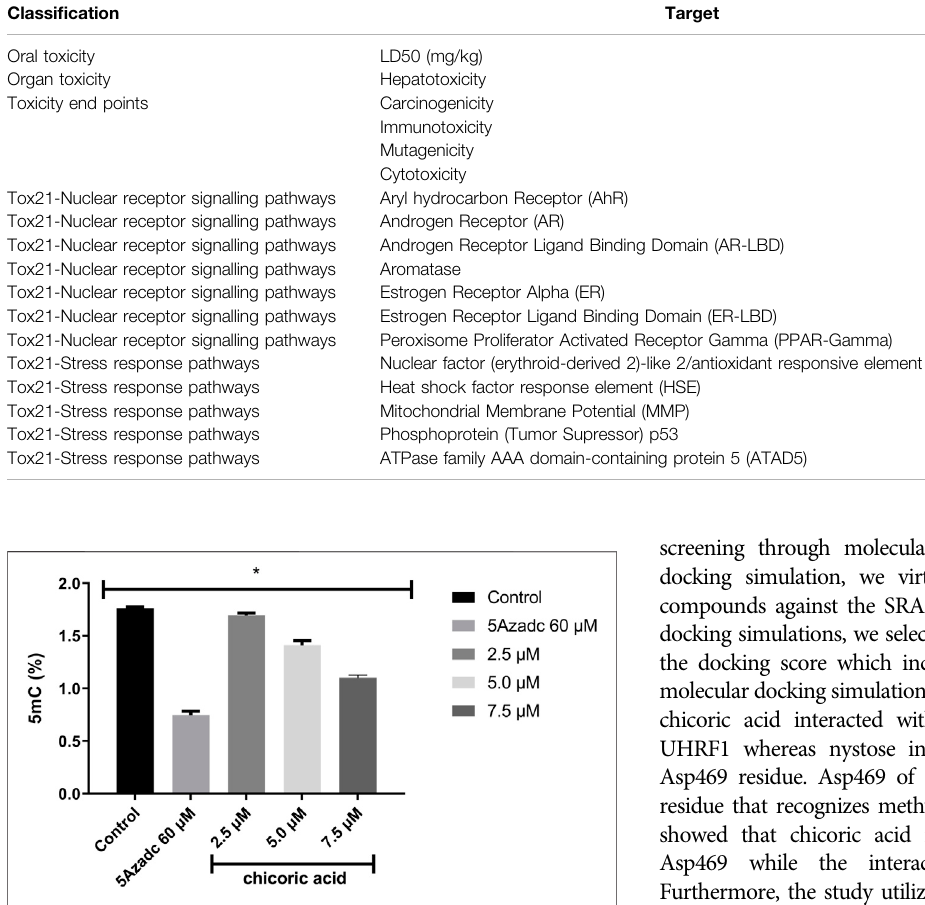
FIGURE 8 | The global genomic methylation level study in chicoric acid treated HCT116 cell line. The percentage of global methylation (5mC) of HCT116 cell line treating with chicoric acid. The concentration of 7.5 µm showed the lowest percentage of methylation (5mC) level. 5Azadc;